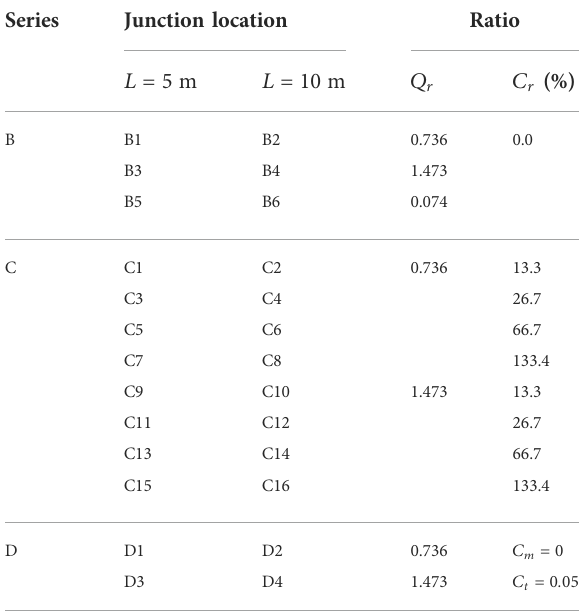
main channel. The tributary-to-main channel sediment